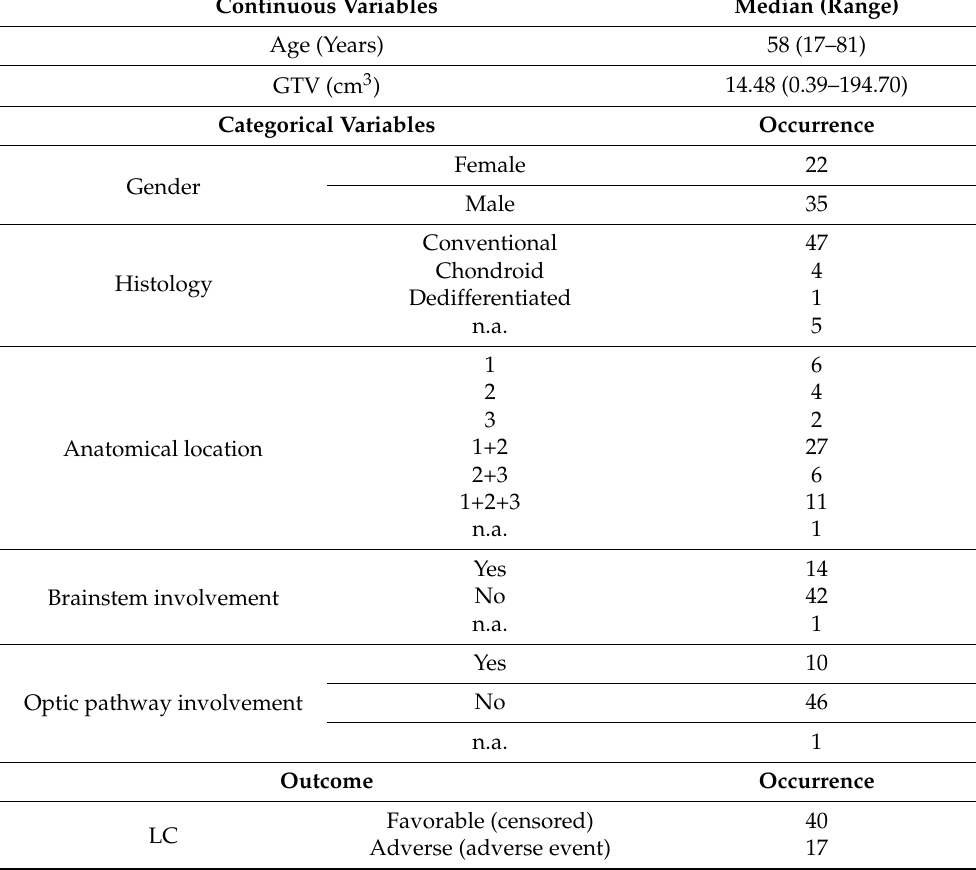
Table 1. Clinical information for the whole dataset, reported as median (range) for continuous variables and occurrences for discrete ones. Anatomical location is coded as upper (1), middle (2) or lower clivus (3), or as a combination of those, as observed with respect to internal anatomical landmarks [29]. GTV—gross tumour volume; LC—local control, n.a.—not available. Continuous Variables Median (Range) Age (Years)